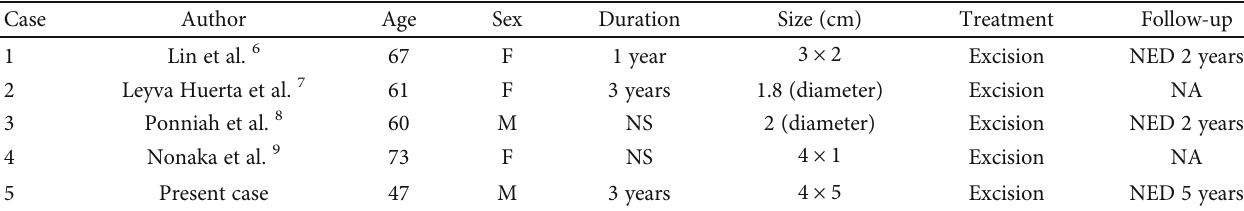
Table 2: Sialolipoma of the fl oor of the